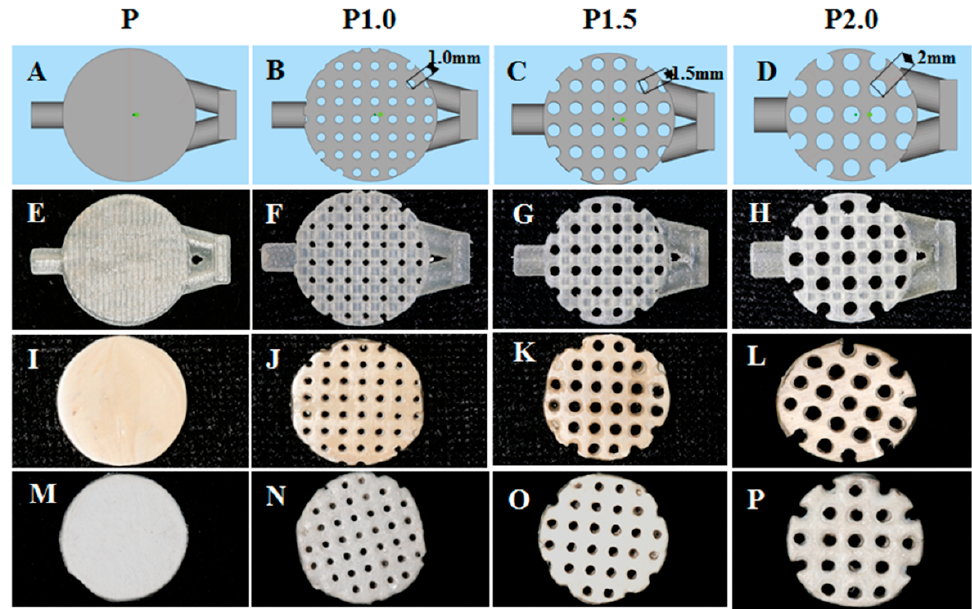
Figure 1. Schematic design and photographs of peek specimens. Computer-designed images of specimens with a cross-linked structure of different sizes: ( A ) P, ( B ) P1.0, ( C ) P1.5, and ( D ) P2.0. Resin molds fabricated by 3D printing of different sizes: ( E ) P, ( F ) P1.0, ( G ) P1.5, and ( H ) P2.0. Peek specimens fabricated by injection-molding technology with different sizes: ( I ) P, ( J ) P1.0, ( K ) P1.5, and ( L ) P2.0. Acid-etched peek specimens fabricated by injection-molding technology with different sizes: ( M ) P, ( N ) P1.0, ( O ) P1.5, and ( P ) P2.0.